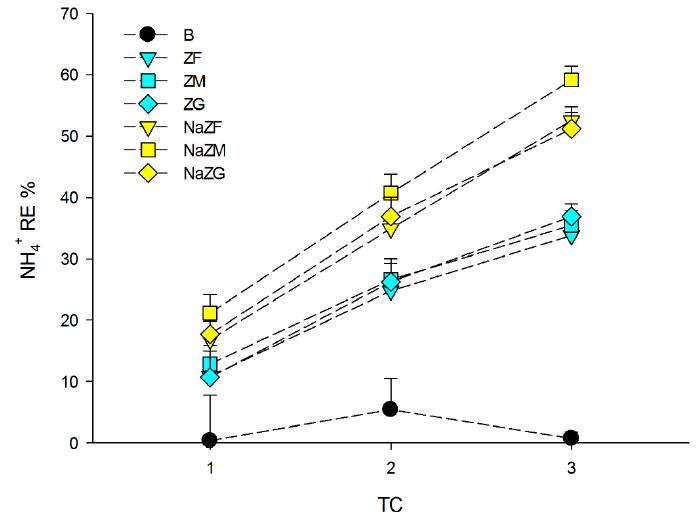
Figure 2. Removal E ffi ciency (RE %) of NH 4 + among the three performed treatment cycles (TC) obtained during the experiments by treating the pig-slurry with natural ZTs in three grain sizes (ZF = grain size 0.1–0.7 mm, ZM = grain size 0.7–2.0 mm and ZG = grain size 2.0-5.0 mm) and Na-homoionic NaZTs in three grain sizes (NaZF = grain size 0.1–0.7 mm, NaZM = grain size 0.7–2.0 mm, and NaZG = grain size 2.0-5.0 mm). Error bars represent standard deviation.